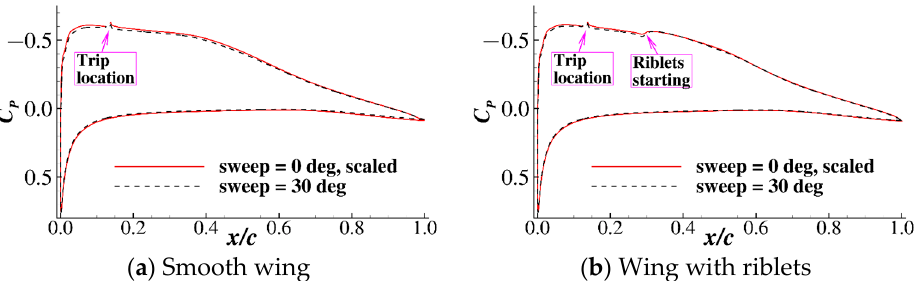
Figure 11. Averaged pressure coefficients of the smooth and riblet-covered wing with and without a sweep angle.